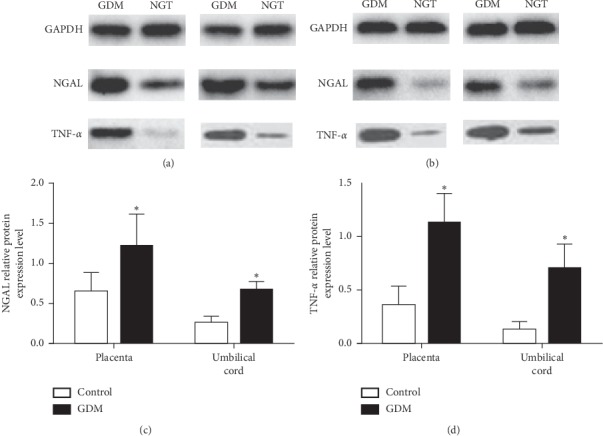
NGAL TNF-α protein expression levels in placental tissues and umbilical cord blood samples of the GDM and the control groups. (a) Representative western blot indicates the differences of NGAL and TNF-α protein expression levels in the placental tissues between the two groups; GAPDH served as an internal control. (b) Representative western blot indicates the differences of NGAL and TNF-α protein expression levels in umbilical cord samples between the two groups; GAPDH served as an internal control. (c) The bar chart indicates quantification of differences in NGAL protein expression levels among the two groups; ∗P < 0.001. (d) The bar chart indicates quantification of differences in TNF-α protein expression levels among the two groups; ∗P < 0.001.